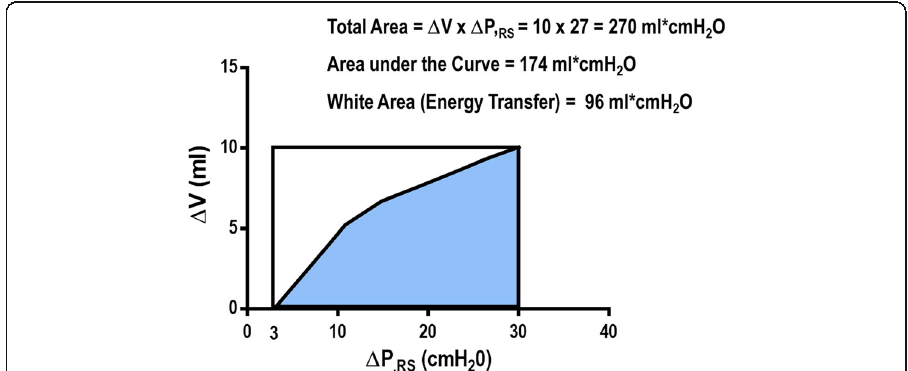
Fig. 1 Experimental quasi-static PV curve from 3 to 30 cmH 2 O performed with a flexiVent® mechanical ventilator (SCIREQ, Montreal, QC, Canada). The total area, obtained by multiplying the volume difference ( Δ V ) by the pressure difference ( Δ P RS ) during the maneuver, was determined (270 mL cmH 2 O). Then, the area under the PV curve was calculated (174 mL cmH 2 O) and subtracted from the total area, yielding the white area (96 mL